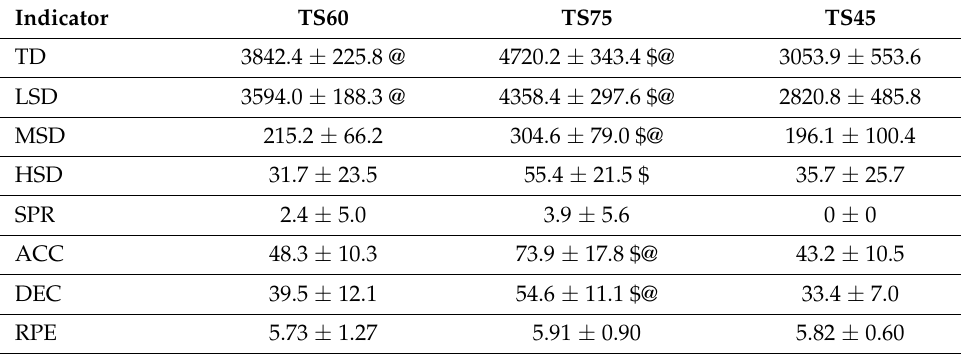
Table 4. Values of GPS indicators and RPE for MD-1 during the three